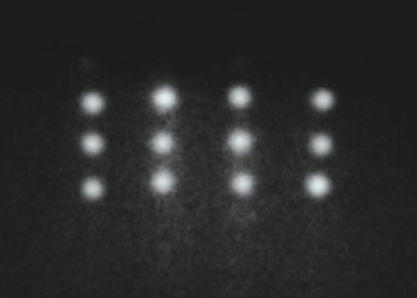
Figure 1: RHEED pattern of the GaN NWs on the SiC buffer layer after 120 minutes of